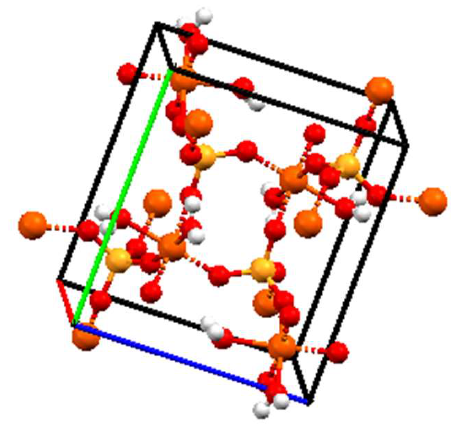
Figure 4. Crystal structure of monoclinic FePO 4 · 2H 2 O. Figure 4. crystal structure of monoclinic FePO 4 ·2H 2 O.